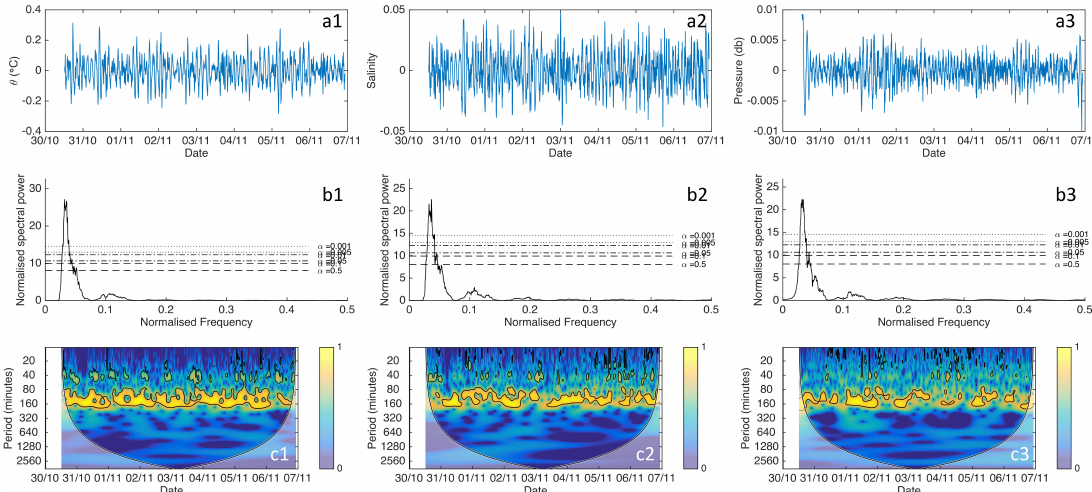
Figure 5. Filtered time series of potential temperature ( a1 ), salinity ( a2 ), and pressure ( a3 ) from an RBR CTD device mounted in a mooring at the interior of the main crater at a 127 m depth. ( b1–b3 ) are the corresponding power spectra and statistical significance computed by fast Fourier transform (FFT). ( c1 – c3 ) are the application of the wavelet transform. The solid contour shows the 95% confidence interval and the light shaded region the cone of influence, representing the area where the wavelet spectrum is affected by edge